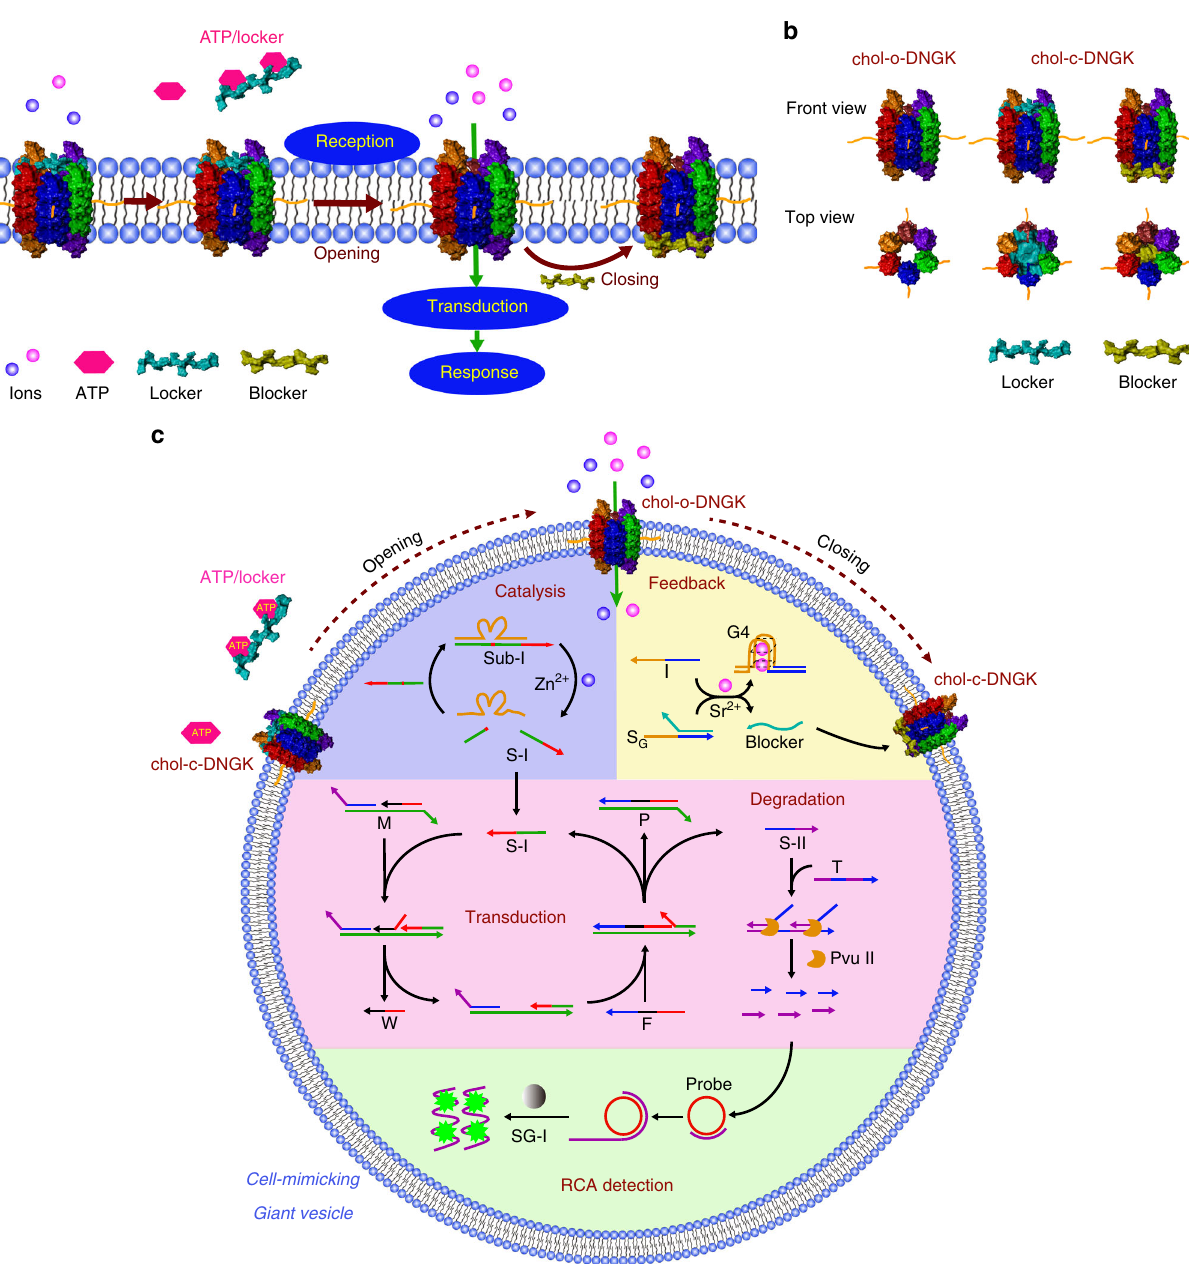
Fig. 1 Biomimetic giant vesicle engineered for the construction of an arti fi cial molecular signaling system (AMSsys). a The whole system was constructed based on a cell-mimicking giant membrane vesicle. Driven by adenosine triphosphate (ATP), the closed state DNA nanogatekeeper switches to the open state. Then, environmental ions diffuse through the opened channel, sequentially triggering a set of con fi ned downstream cascade reactions, and an additional feedback pathway mediates the switching of nanogatekeeper back to the closed state. This process mimics the fundamental cellular signaling that contains reception, transduction, and response. b Schematic illustration of chol-o(open)-DNGK and chol-c(closed)-DNGK. A locker (cyan DNA strand) can plug the nanogatekeeper in the top region; similarly, a blocker (yellow DNA strand) can plug the nanogatekeeper in the bottom region, both locker and blocker can form a closed nanogatekeeper. c Modular design of AMSsys in giant membrane vesicles corresponding to a , consisting of membrane-spanning nanogatekeeper and the encapsulated signaling network, which is divided into the following modules: ion-mediated catalytic reaction, a DNA circuit signaling transduction, and a target degradation. The rolling circle ampli fi cation (RCA) in the end is used to detect the fi nal